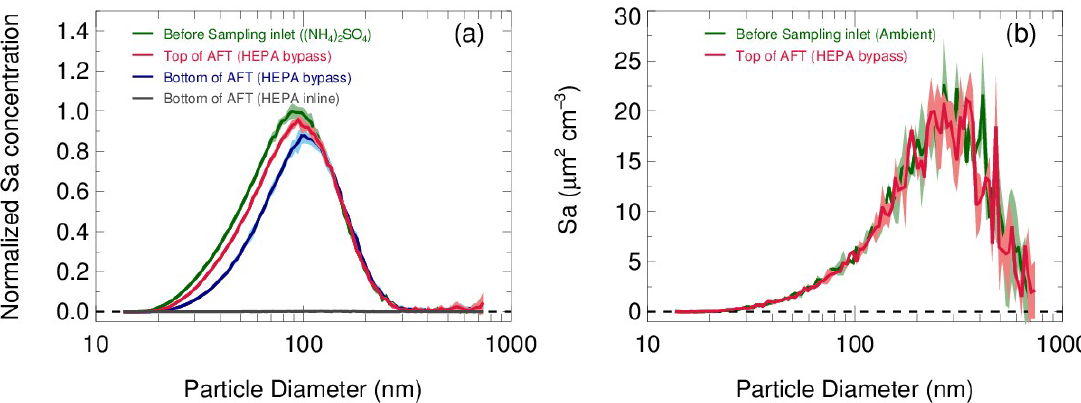
Figure 7. (a) Particle transmission determined by sampling laboratory-generated ( NH 4 ) 2 SO 4 aerosols. Aerosols at different concentrations and RH levels are used in experiments, and the size distributions of S a concentrations are normalized to the peak values. The normalized size distributions of S a concentrations measured before the sampling inlet (green line), at the inlet of the flow tube with the HEPA bypass (red line) and at the bottom of the flow tube with the HEPA bypass (blue line) are shown respectively. Under the HEPA inline mode, the S a concentration was almost zero at the bottom of flow tube (gray line). The shadows indicate the standard deviations of the normalized S a concentrations for all experiments. (b) Particle transmission determined by sampling ambient particles.